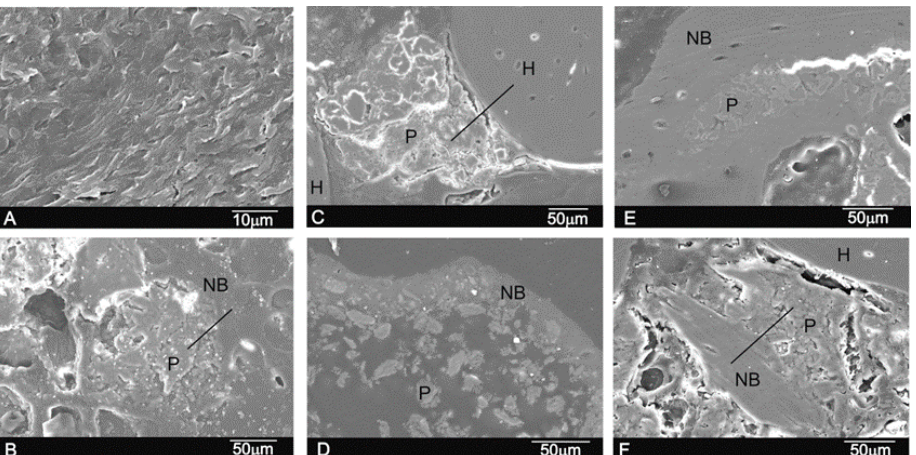
Figure 5. SEM images of the scaffold’s cross ‐ section after ( A , B ) 15 days ( C , D ) 30 days and ( E , F ) 60 implantation days (H denotes a pore filled with new bone, P refers to implant particles that result from the degradation process, and NB represents new bone tissue).